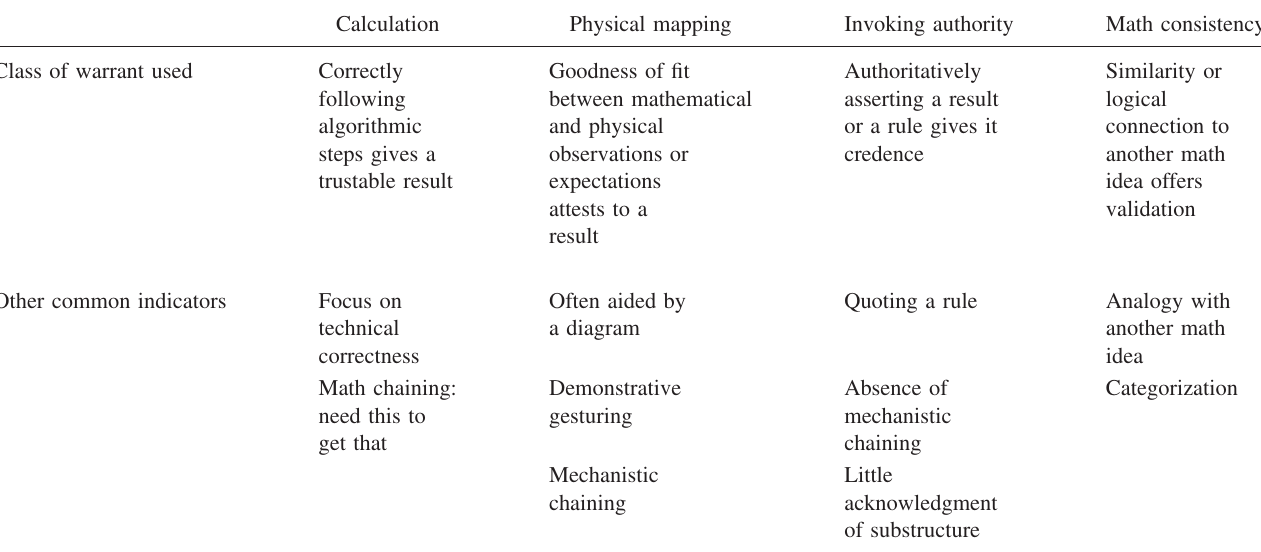
TABLE I. Four common framings and their primary (cid:1) i.e., warrants (cid:2) and secondary